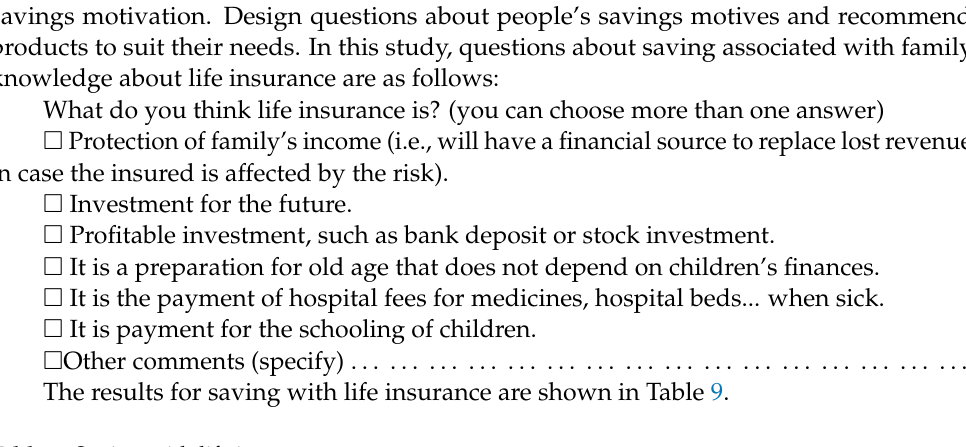
Table 9. Saving with life